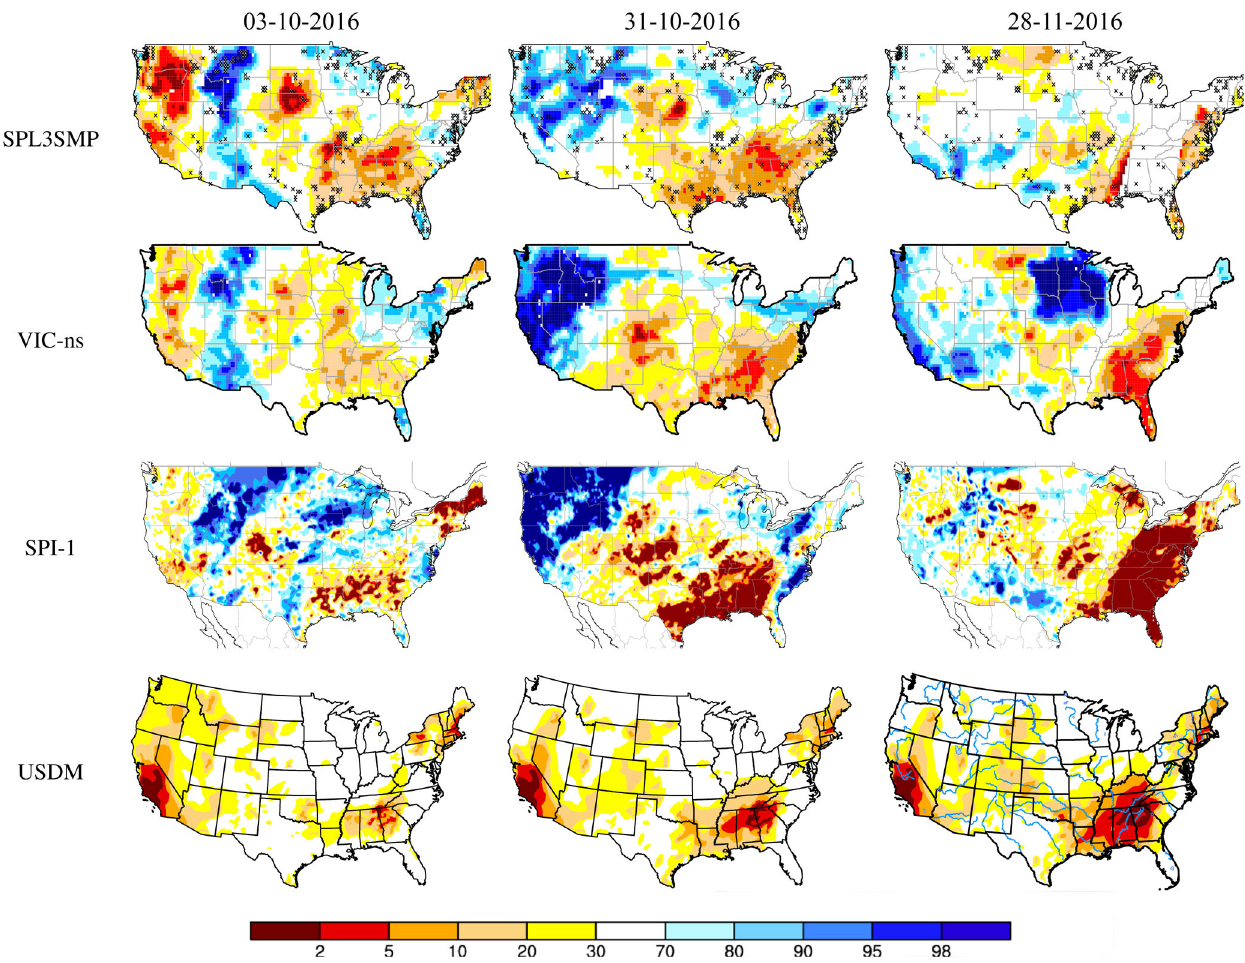
Figure 8. Comparison between SPL3SMP index map and VIC-ns, SPI-1 and USDM in 2016. The black x symbols in the SPL3SMP maps are the grids that passed neither filter and were shown as white grids in Fig. 6. For USDM, drought levels from 30 to 100 are shown in